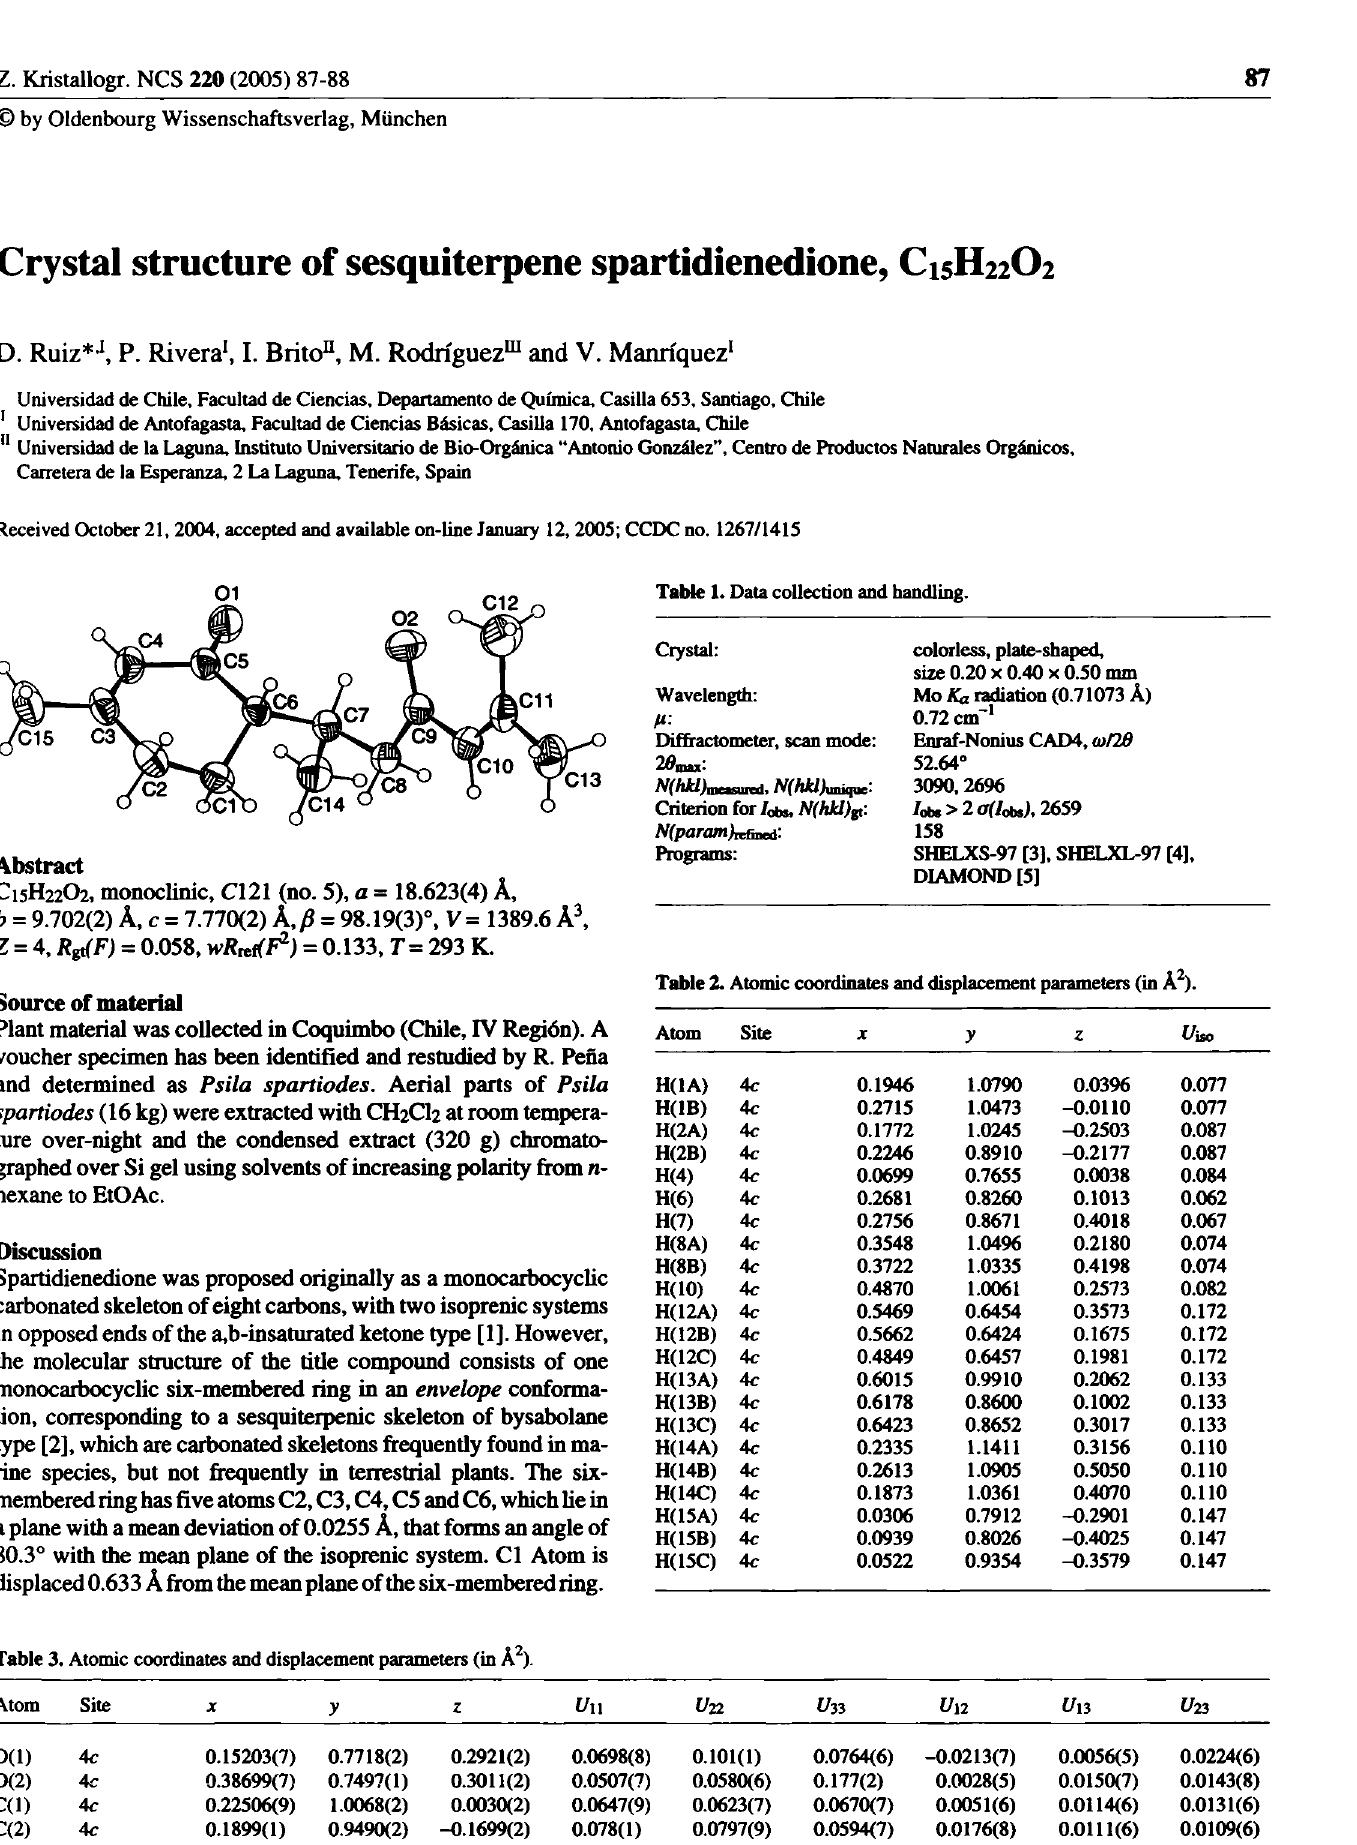
Table 3. Atomic coordinates and displacement parameters (in Ä 2